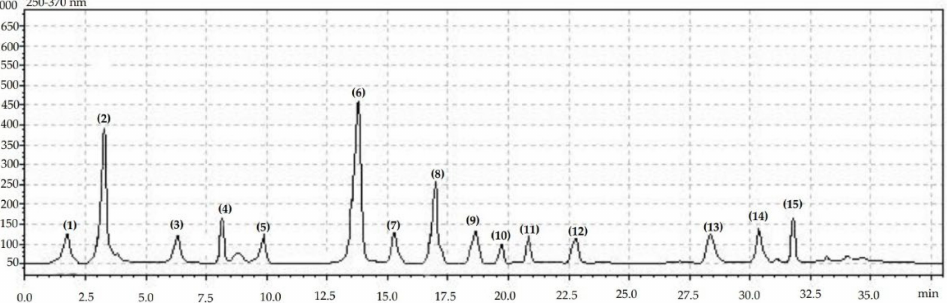
Figure 2. Chromatogram showing retention times for identified phenolic compounds: ( 1 ) phe- nols unknown, ( 2 ) gallic acid, ( 3 ) phenols unknown, ( 4 ) phenols unknown, ( 5 ) phenols unknown, ( 6 ) chlorogenic acid, ( 7 ) catechin, ( 8 ) epigallocatechin, ( 9 ) caffeic acid, ( 10 ) quercetin-3-O-rutinoside, ( 11 ) p -coumaric acid, ( 12 ) ferulic acid, ( 13 ) luteolin, ( 14 ) quercetin, ( 15 )